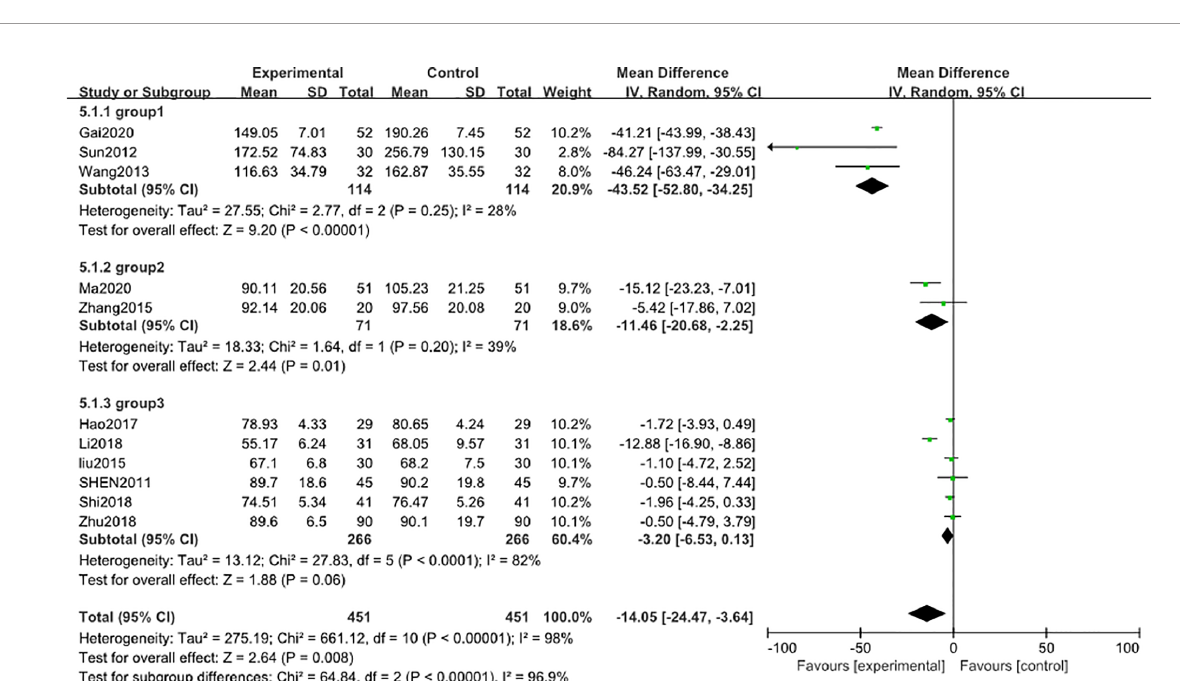
FIGURE 5 | Subgroup analysis of blood creatinine level after 3 months: comparison of treatment combined with TG against basic treatment (group 1: range 160- 200 m mol/L, group 2: range 99-130 m mol/L, group 3: range 60-92 m